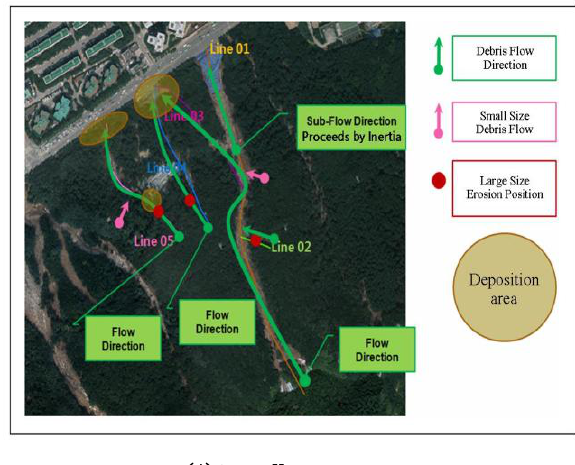
Figure 9. Assessment of the debris flow